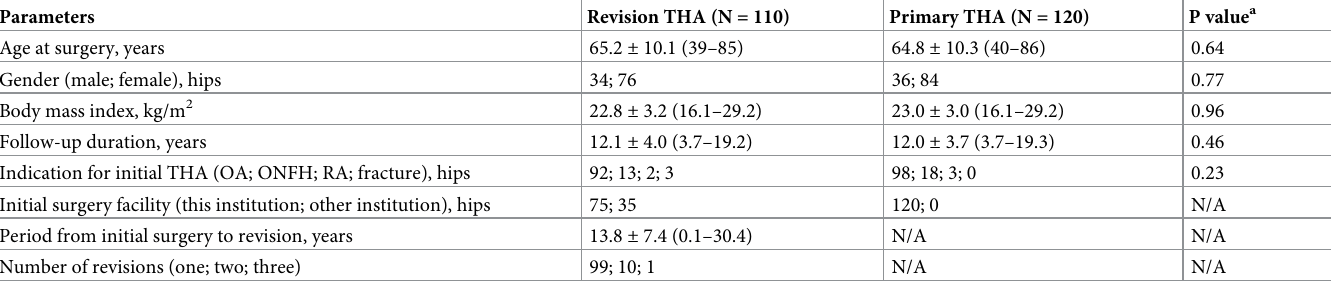
Table 1. Patients demographics of propensity score-matched